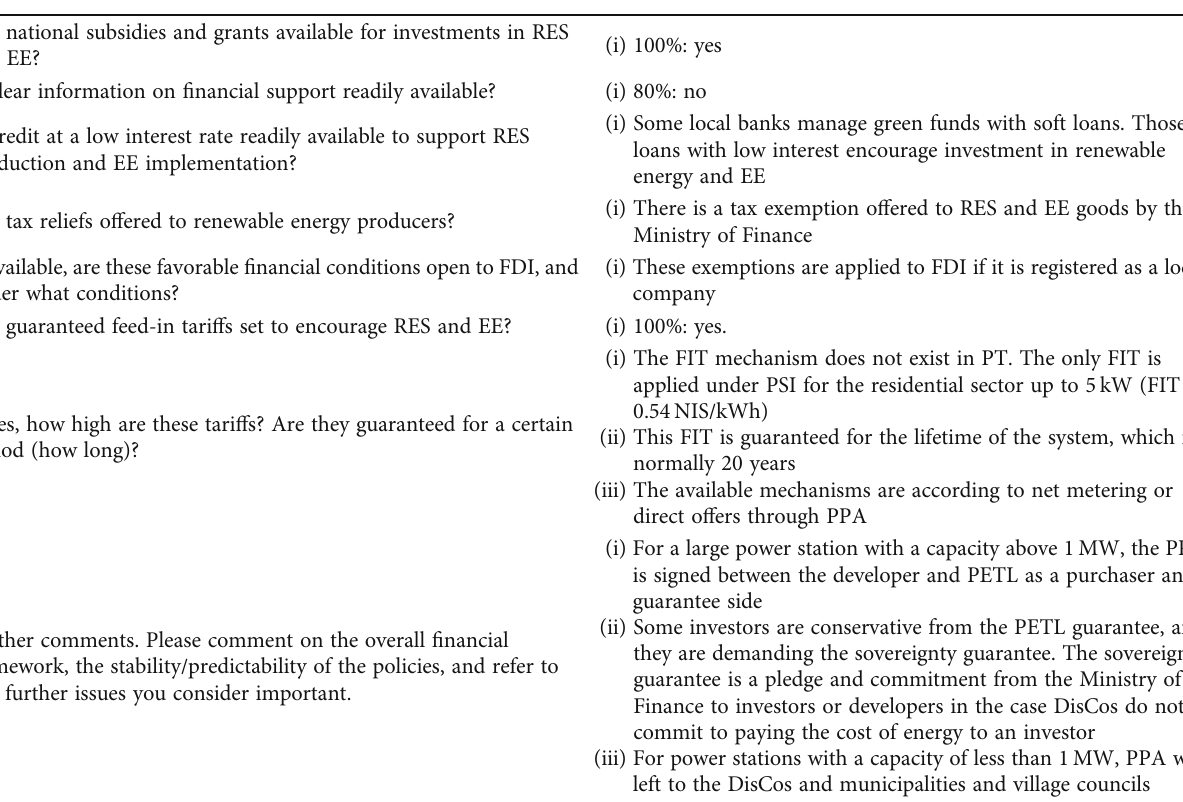
Table 3: Summarization of answers of public institutions to questions related to fi nancial incentives for RES and EE. Are national subsidies and grants available for investments in RES and